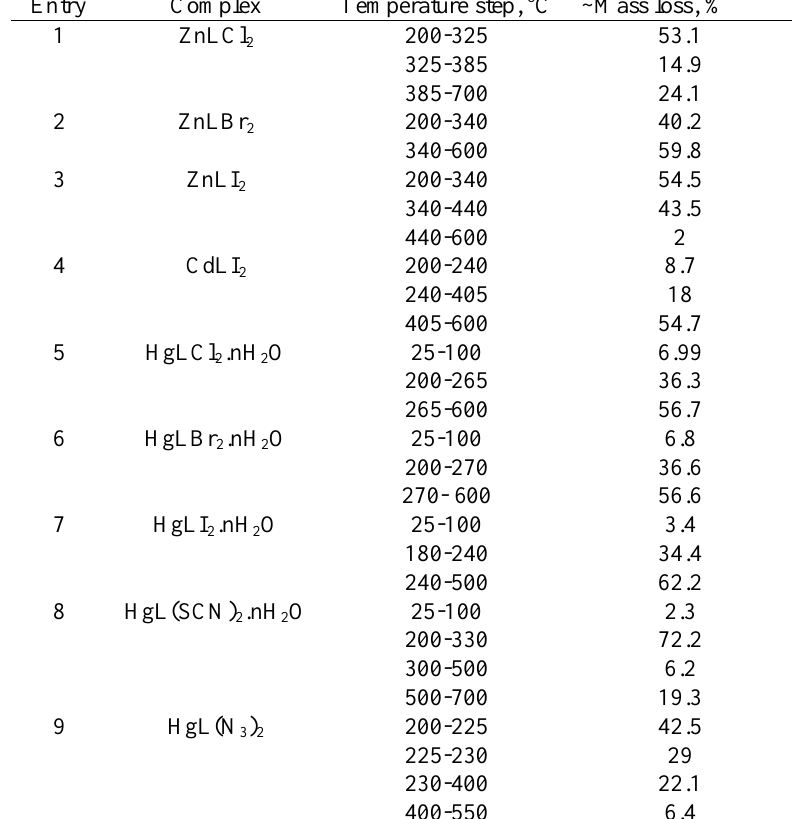
Table 2. Thermal analysis data including temperature range, mass loss and proposed residue.